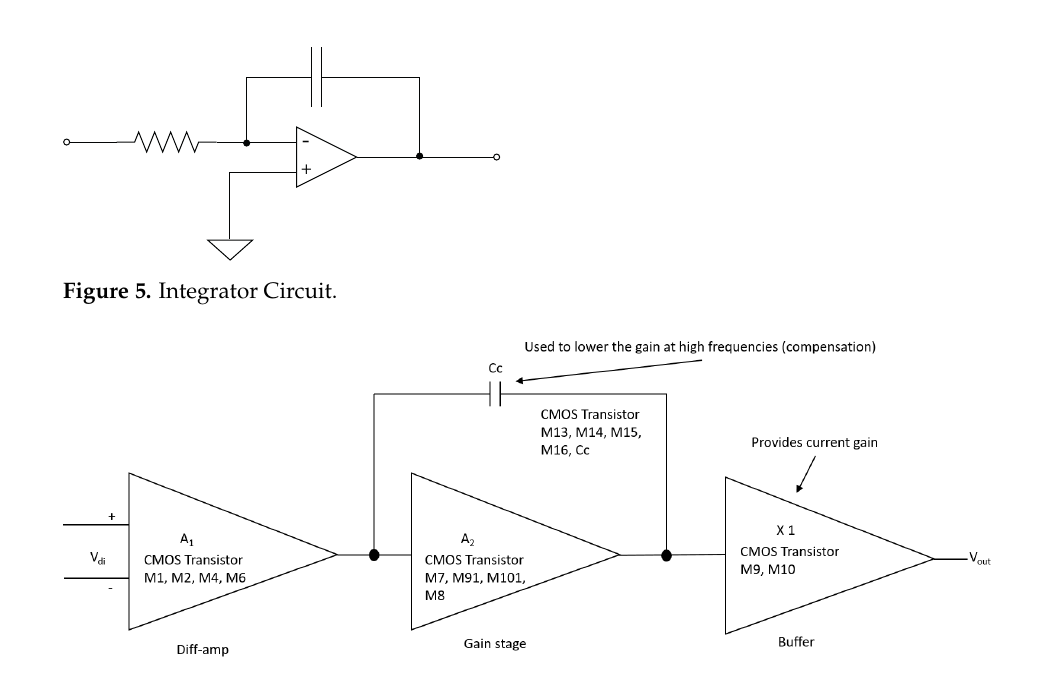
Figure 6. Block diagram of the 1.2 µ m operational amplifier. Table 3. Parameters of CMOS